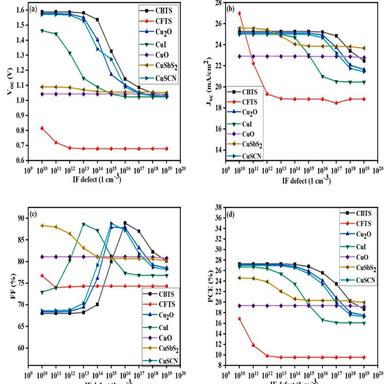
Interface defect effect at HTL/Perovskite versus SC performance parameters with ETL ZnSe.